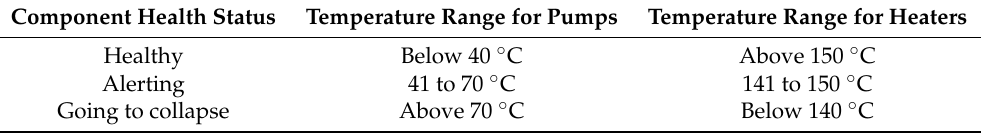
Table 3. Component health status thresholds for both pumps and